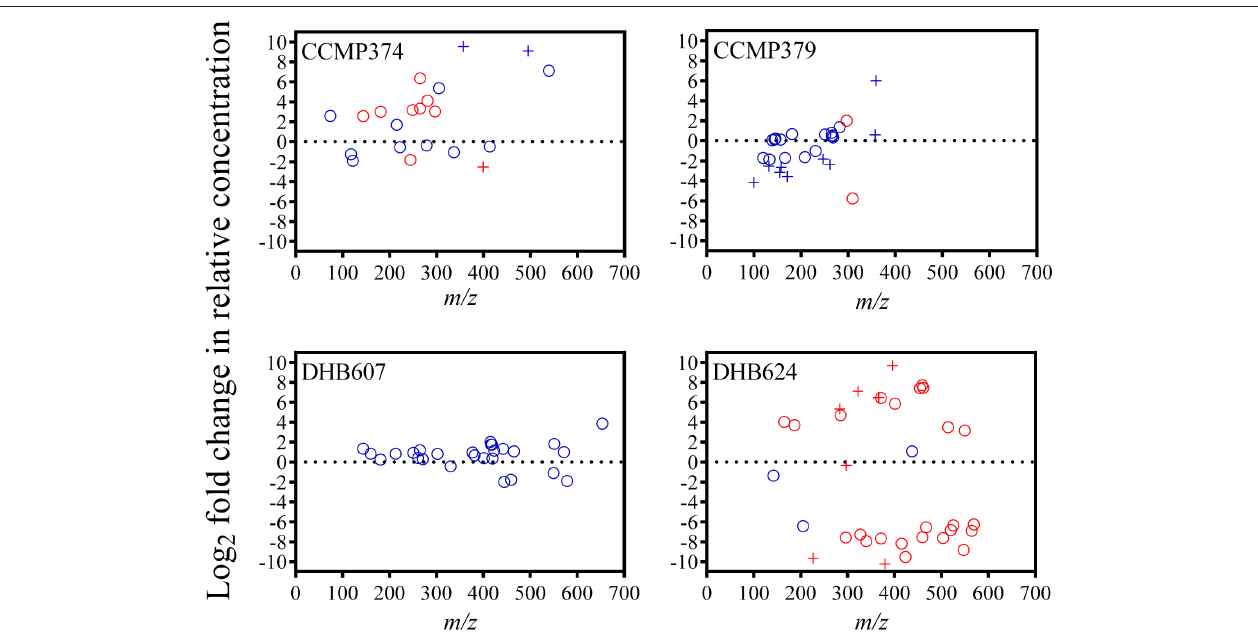
FIGURE 3 | Fold changes of chemical features (circles) detected in the exometabolomes of four Emiliania huxleyi strains (CCMP374, CCMP379, DHB607, and DHB624) exposed to the predator Oxyrrhis marina, arranged according to m/z . Fold change was calculated as the Log 2 of the ratio between feature peak area in grazed vs. control (i.e., not grazed) extracts. Features with peak areas that were significantly different (unpaired t -test with FDR < 0.05 correction) in extracts of grazed and control cultures are colored red. Pluses ( + ) indicate features that were not present in extracts of grazer only cultures.